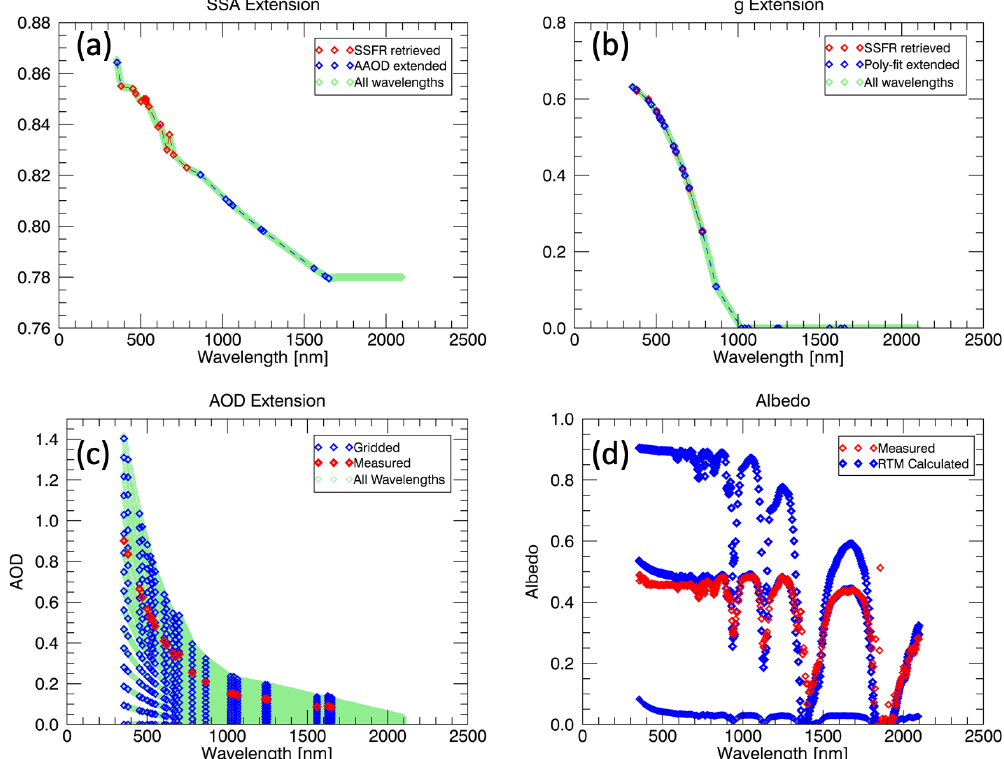
Figure A1. One example case of the extension of aerosol properties to longer wavelengths for (a) SSA, (b) g , and (c) AOD. Panel (d) shows the SSFR-measured vs. RT-calculated albedo spectra along with the RT-calculated spectra for 0 COT and 100 COT.